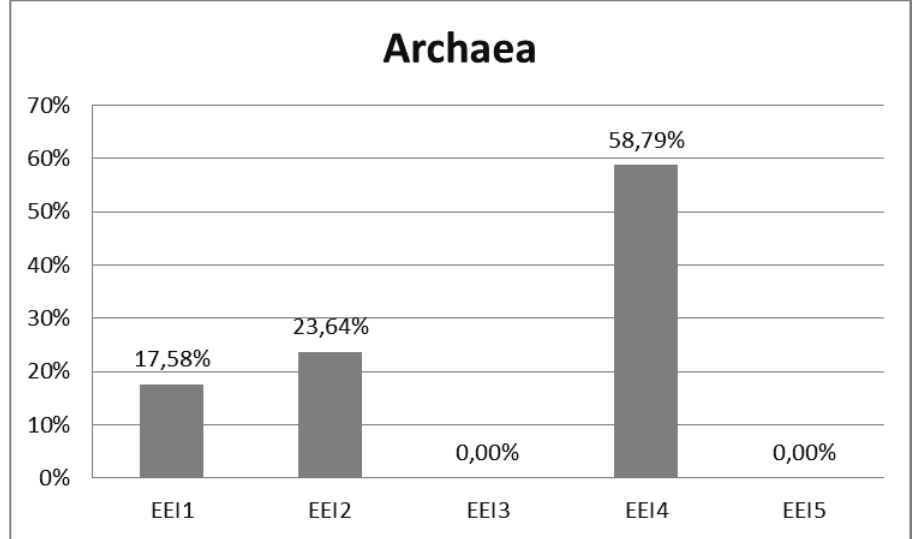
Fig. 5. Distribution of 165 Archaea genomes to five types of the